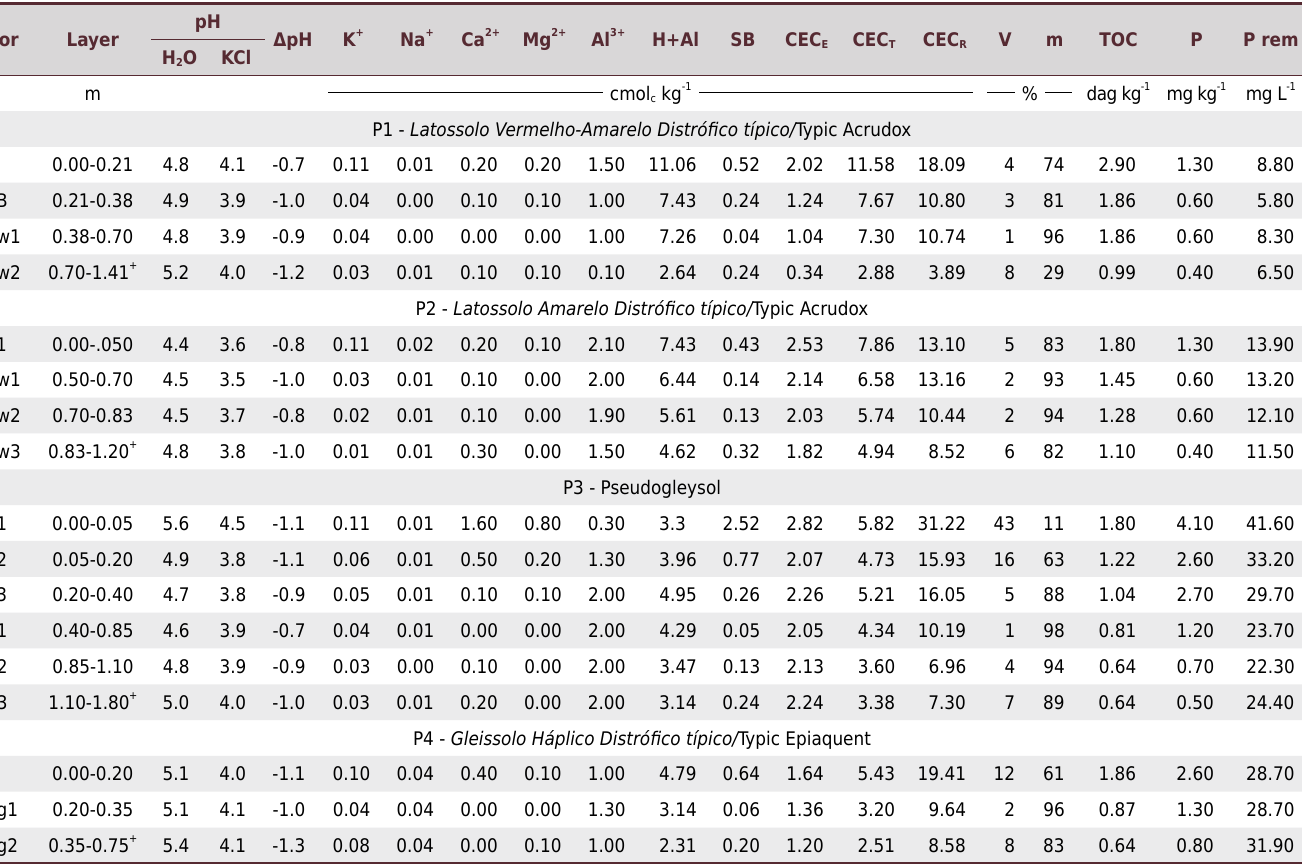
Table 2. Chemical characterization of soils Hor Layer